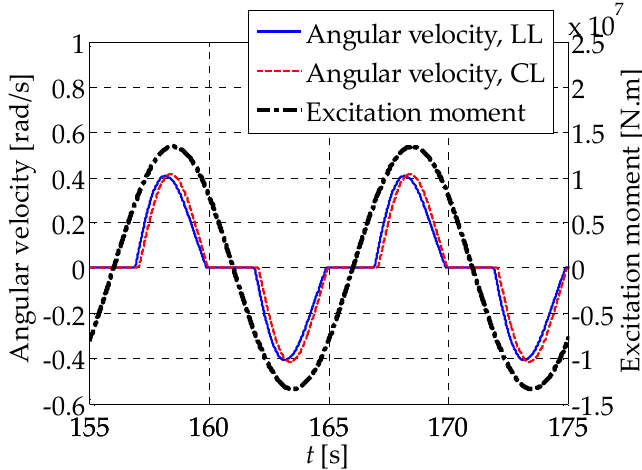
Figure 7. Time history of the angular velocity and excitation moment when the maximum relative capture width is achieved for both the linear load and coulomb loads at T = 10 s.